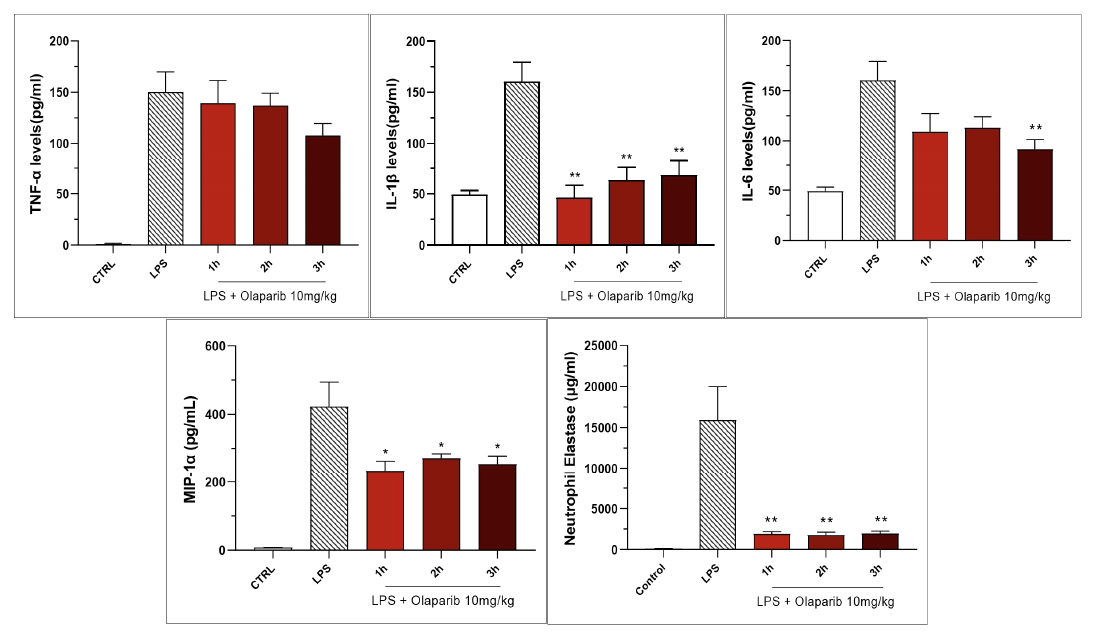
Figure 21. Effect of olaparib post-treatment on selected cytokine and chemokine levels in the bron- choalveolar lavage fluid in a murine model of ALI. C57Bl/6 mice received either PBS (30 µ L) or LPS (50 µ g in 30 µ L PBS) by intratracheal instillation in the absence or presence of 10 mg/kg olaparib, delayed to 1, 2, or 3 h post-LPS. After 24 h, bronchoalveolar lavage fluid was collected, and mediator levels were measured. * p < 0.05 and ** p < 0.01 indicate the beneficial effect of olaparib in LPS-treated animals. Data are shown as mean ± SEM, n =